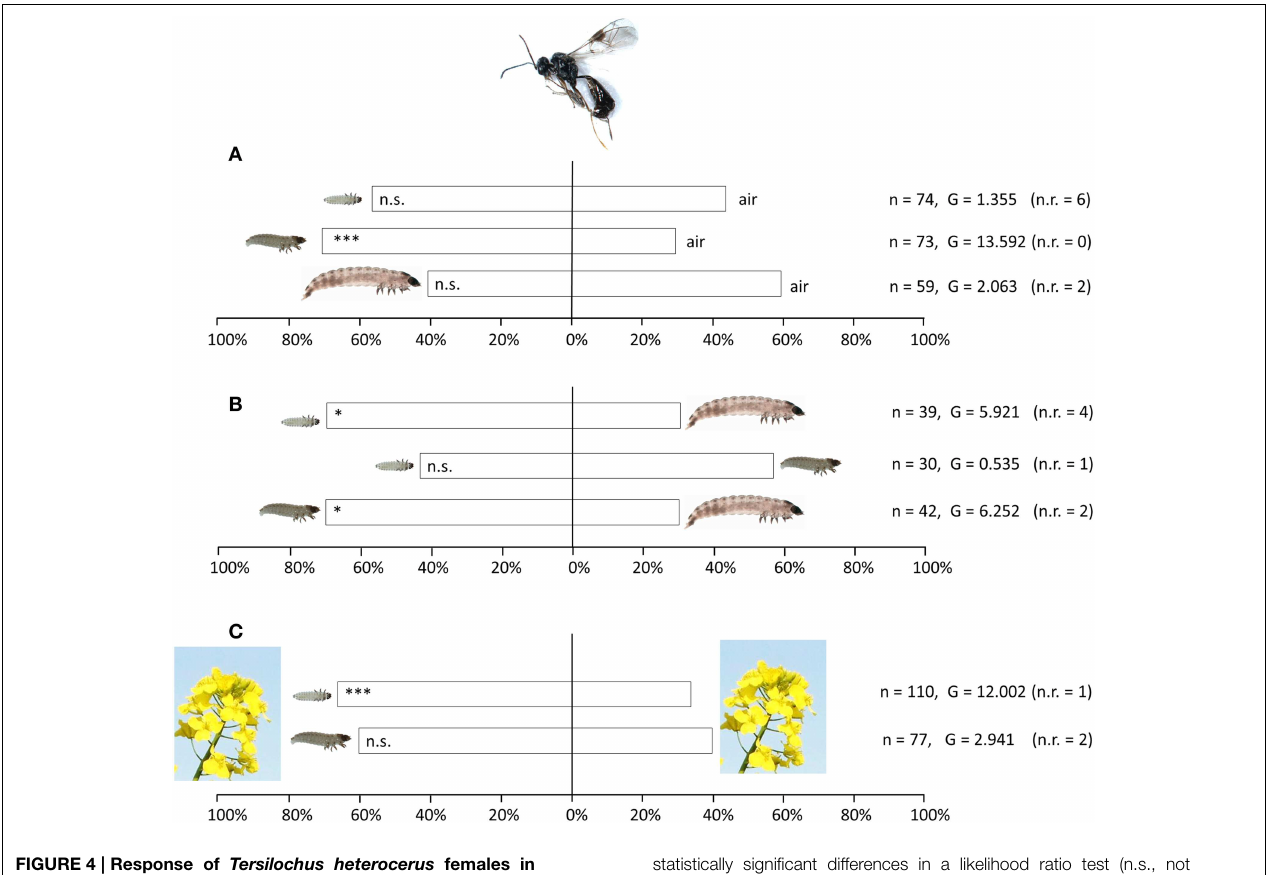
FIGURE 4 | Response of Tersilochus heterocerus females in Y-tube experiments to odors from pollen beetle larvae in three size categories. (A) Larvae tested against purified air, (B) Larval size categories tested against each other, (C) Larvae and flowering oilseed rape tested against flowering oilseed rape only. Asterisks indicate